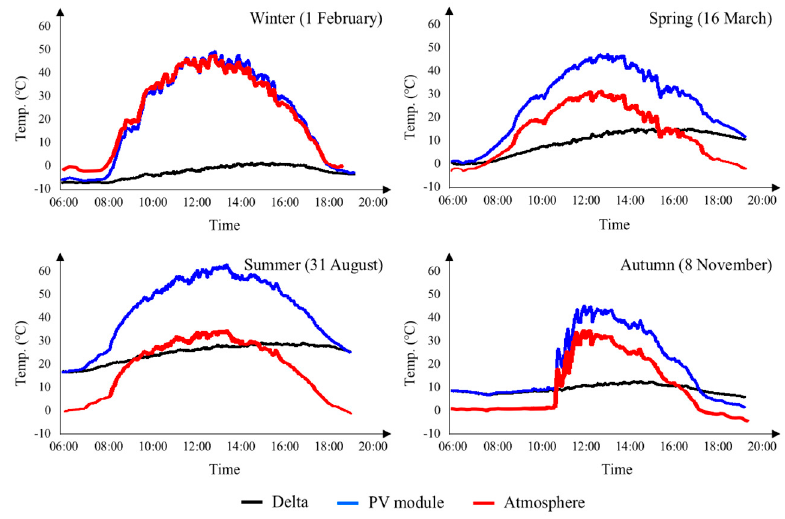
Figure 1. Photovoltaic (PV) module temperature change according to seasonal temperature.